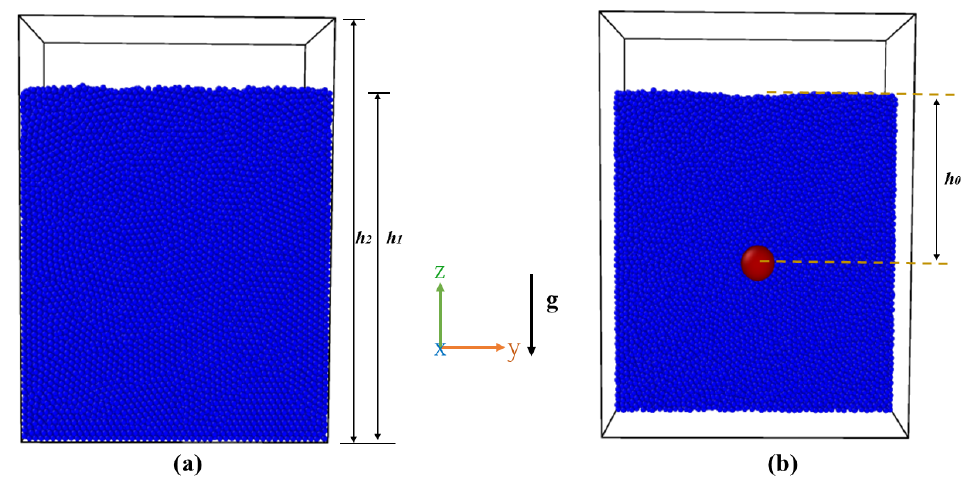
Figure 1. The simulated system: ( a ) the initial state, with h 2 = 1.3 m the height of the container and h 1 = 1.0 m the height of the bed medium; ( b ) a cross-section at x = 0, showing the initial SO at depth h 0